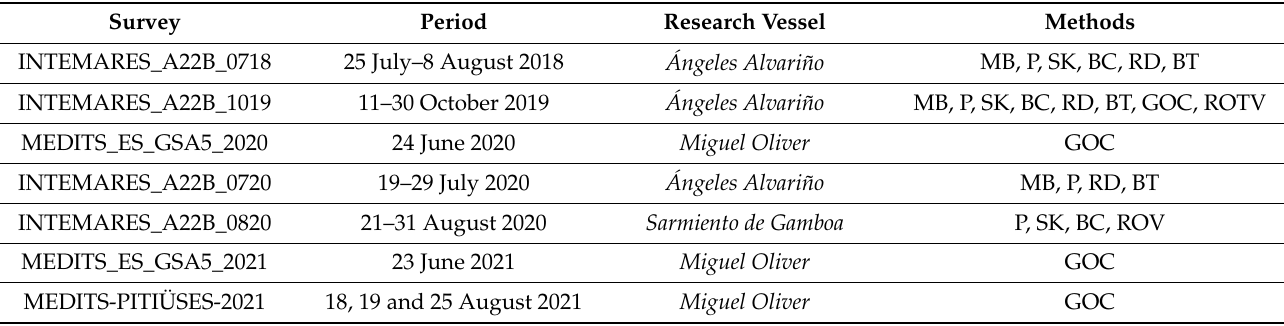
Table 1. Summary of the research surveys developed in the Ses Olives, Ausias March, and Emile Baudot seamounts and adjacent bottoms of the Mallorca Channel (Balearic Islands, western Mediter- ranean) during the INTEMARES and MEDITS projects, showing the methods applied to obtain the data and samples: multibeam (MB) and parametric (P) echosounders, Shipek (SK), Box–Corer (BC) and rock (RD) dredges, beam trawl (BT), the experimental bottom trawl GOC-73 (GOC), photogram- metric sledge (ROTV), and remote operated vehicle